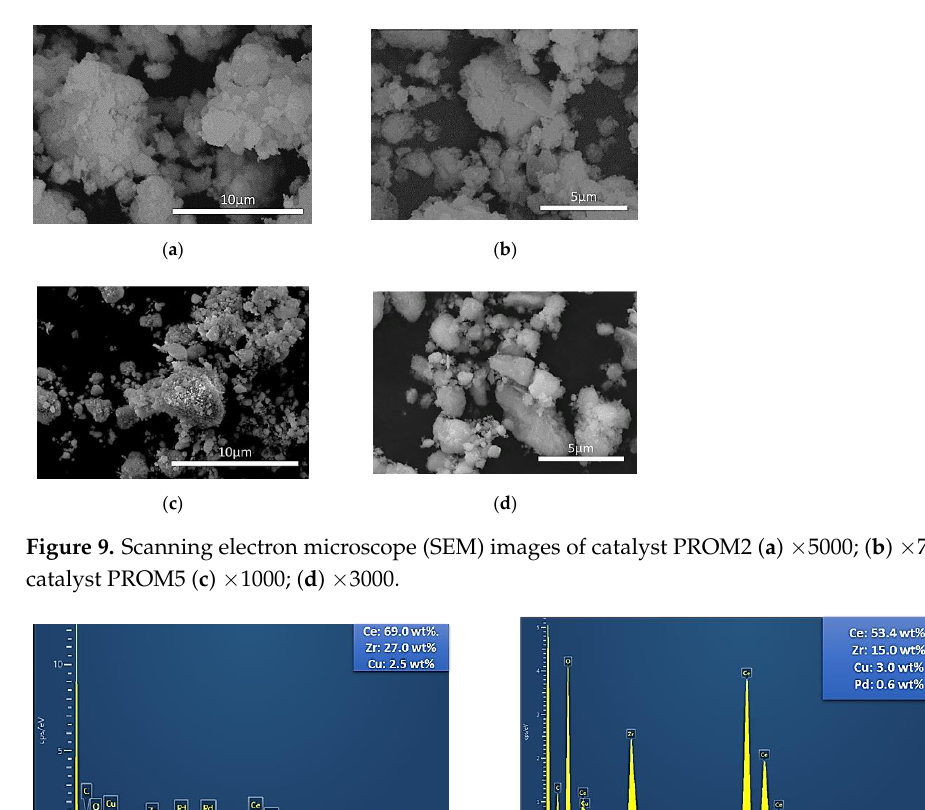
( b ) Figure 8. Raman spectrum of the samples CZ, PROM2, PROM5 ( a ) 10-4000cm −1 ; ( b ) 10-1100cm −1 . Finally, the bands at 1205, 1207, 1225 cm −1 for CZ, PROM2 and PROM5 respectively, and the low frequency bands at 614, 610 and 599 cm −1 for CZ, PROM2 and PROM5, as well, correspond to the defect-induced bands Ce-O of the cubic phase of the CZ substrate. These spectral changes, are in accordance to XRD results, where [220] and [311] crystal planes are affected by the addition of the catalytic phase on the substrate, indicating that the possible doping and Ce ion substitution might have taken place upon substrate im- pregnation. 3.1.3. Scanning Electron Microscopy (SEM)—Energy-Dispersive X-ray Spectroscopy